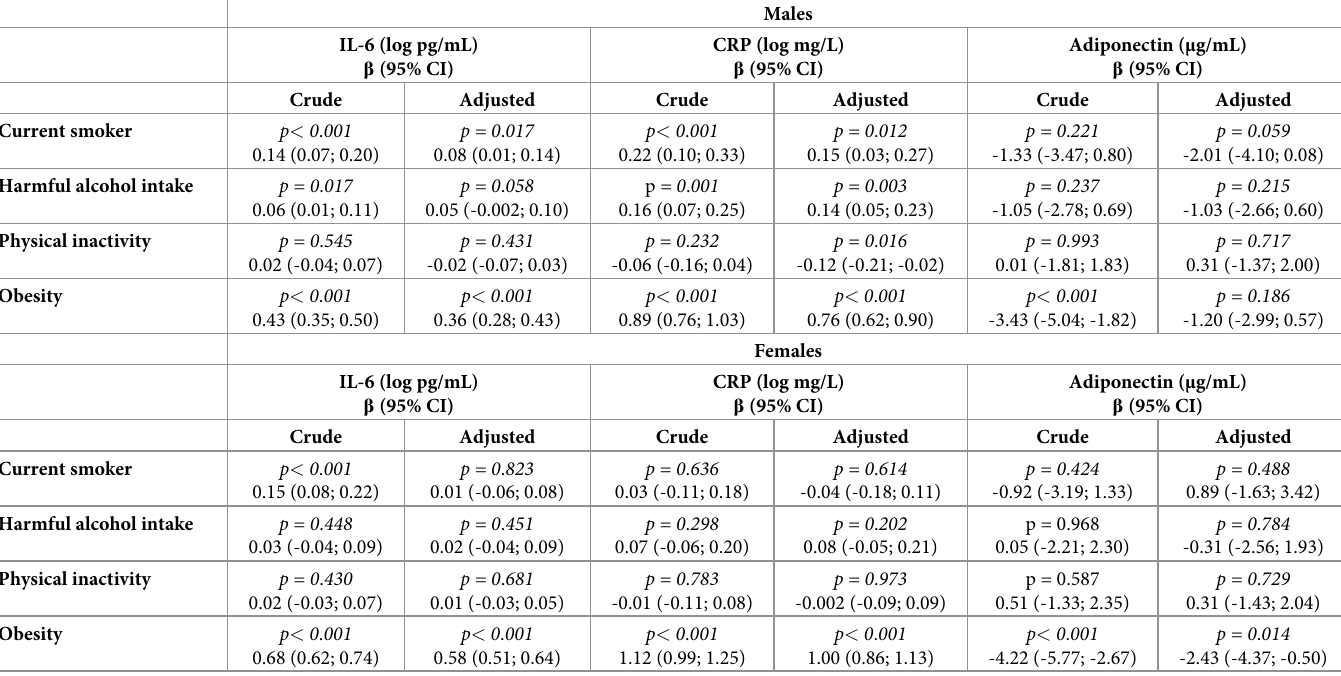
Table 4. Crude and adjusted GLS random-effects models between risk factors and IL-6, CRP and adiponectin at 18 and 22